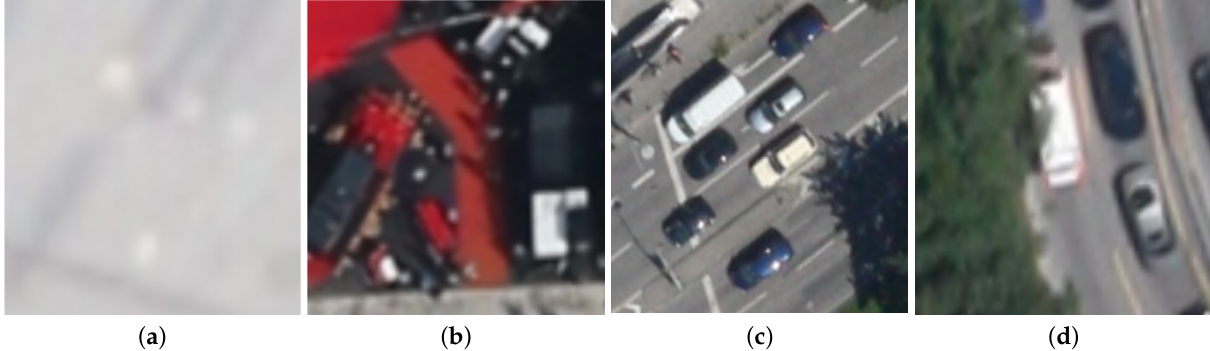
Figure 2. Illustrations of some challenges in aerial MOT datasets. The examples are from the KIT AIS pedestrian ( a ), AerialMPT ( b ), and KIT AIS vehicle datasets ( c , d ). Multiple pedestrians which are hard to distinguish due to their similar appearance features and low image contrast ( a ). Multiple pedestrians at a trade fair walking closely together with occlusions, shadows, and strong background colors ( b ). Multiple vehicles at a stop light where the shadow on the right hand side can be problematic ( c ). Multiple vehicles with some of them occluded by trees ( d